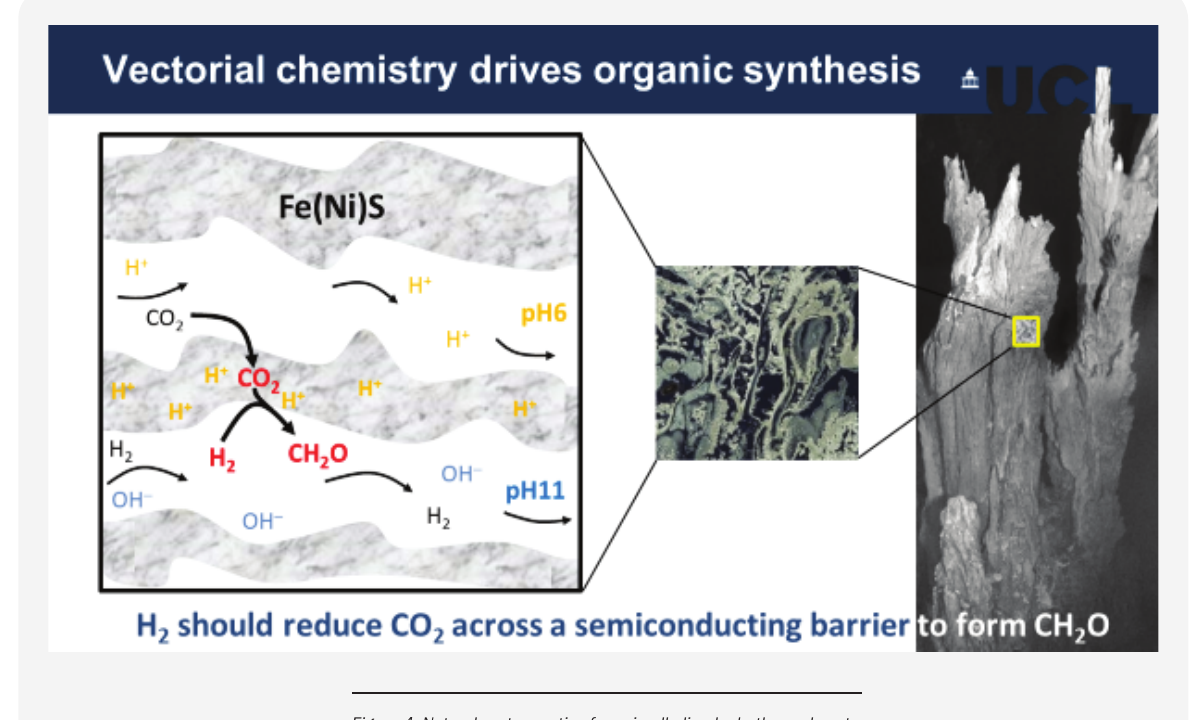
ow.Figure 4. Natural proton-motive force in alkaline hydrothermal